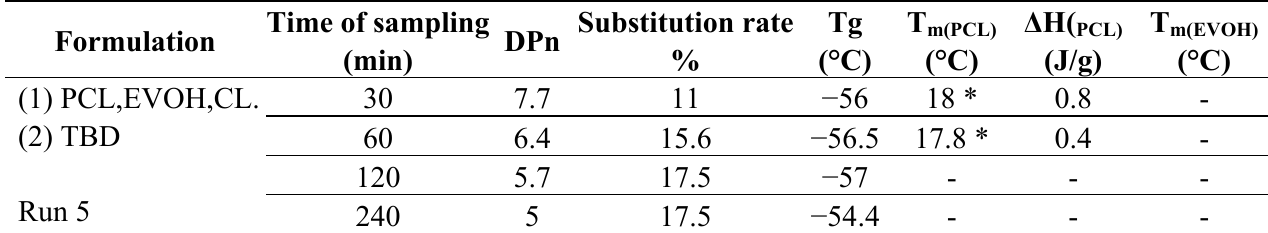
Table 3. 1 H NMR and thermal analysis data obtained for run 5.